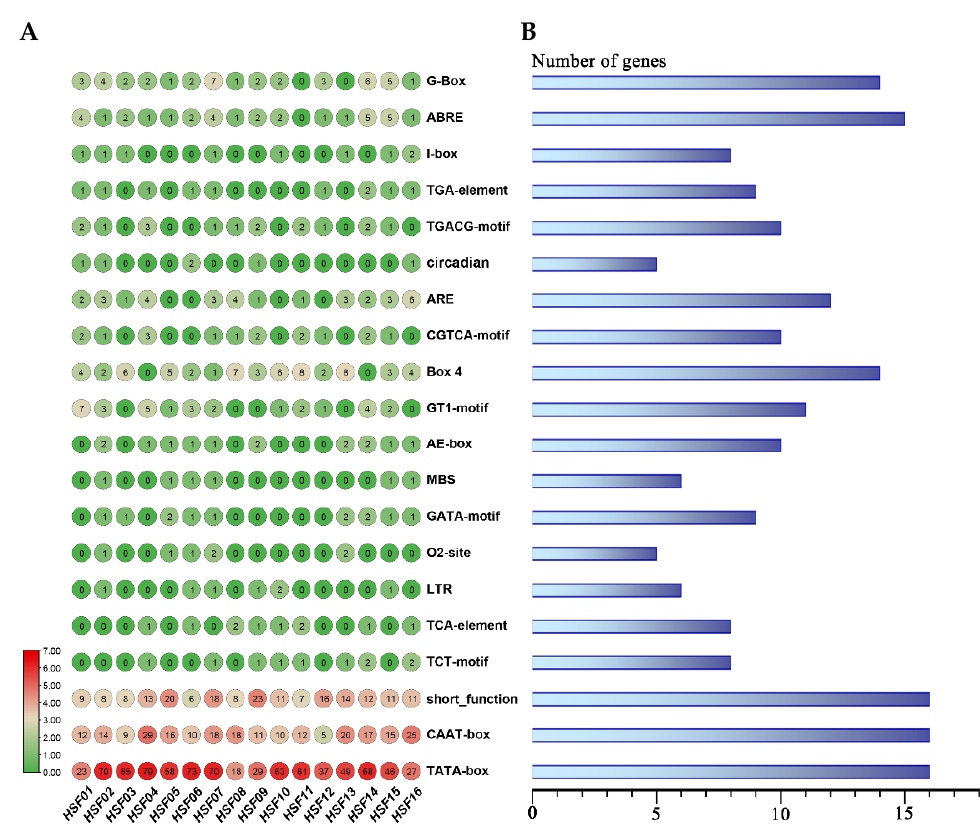
Figure 8. A schematic representation of the cis-acting elements identified in the 2000 bp promoter region upstream of the MsHSF gene. The different colors represent the number of cis-acting elements contained ( A ). The number of MsHSF genes corresponding to the cis-acting element ( B ).